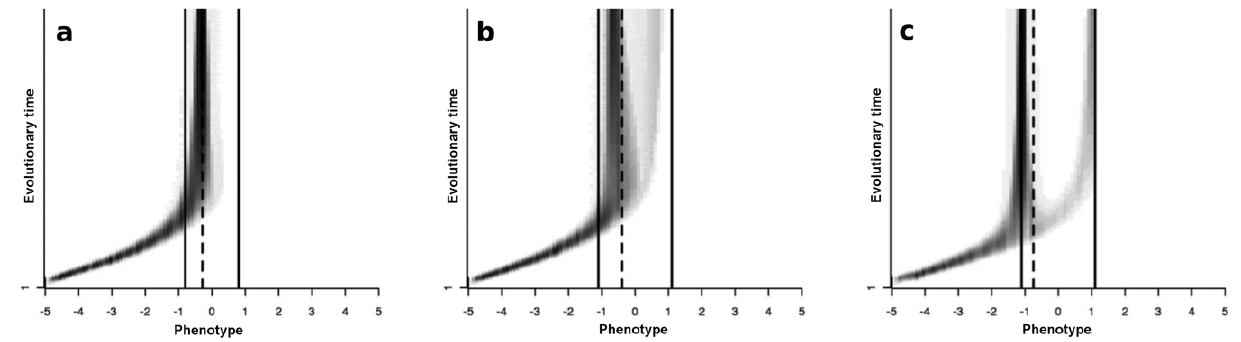
Figure 3. Examples of evolutionary trajectories simulated from Equation (1) on the lattice environment. The branching criterion (Equation (4)) is equal to 0.6 (a), 1.07 (b) and 7.5 (c). When it is lower than one, the generalist strategy is stable (a). Otherwise, the metapopulation splits into two sub-populations of specialists (b and c). Dashed line: theoretical singular strategy ( x ? ), solid lines: habitat optima ( b 1 and b 2 ). Other parameters are: a: d = s ~ 0 : 8 ( d ~{ b 1 ~ b 2 ~ 0 : 8 and s ~ 1 ), m s ~ 0 : 75, p ~ 0 : 32 , AI ~ 0 : 1 ; b: d = s ~ 1 : 1 ( d ~{ b 1 ~ b 2 ~ 1 : 1 and s ~ 1 ), m s ~ 0 : 75 , p ~ 0 : 32 , AI ~ 0 : 1 ; c: d = s ~ 1 : 1 ( d ~{ b 1 ~ b 2 ~ 1 : 1 and s ~ 1 ), m s ~ 0 : 15 , p ~ 0 : 16 , AI ~ 0 : 7 .